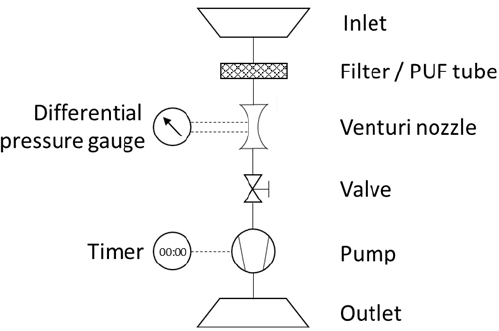
Figure 1. Main components of a typical high-volume air